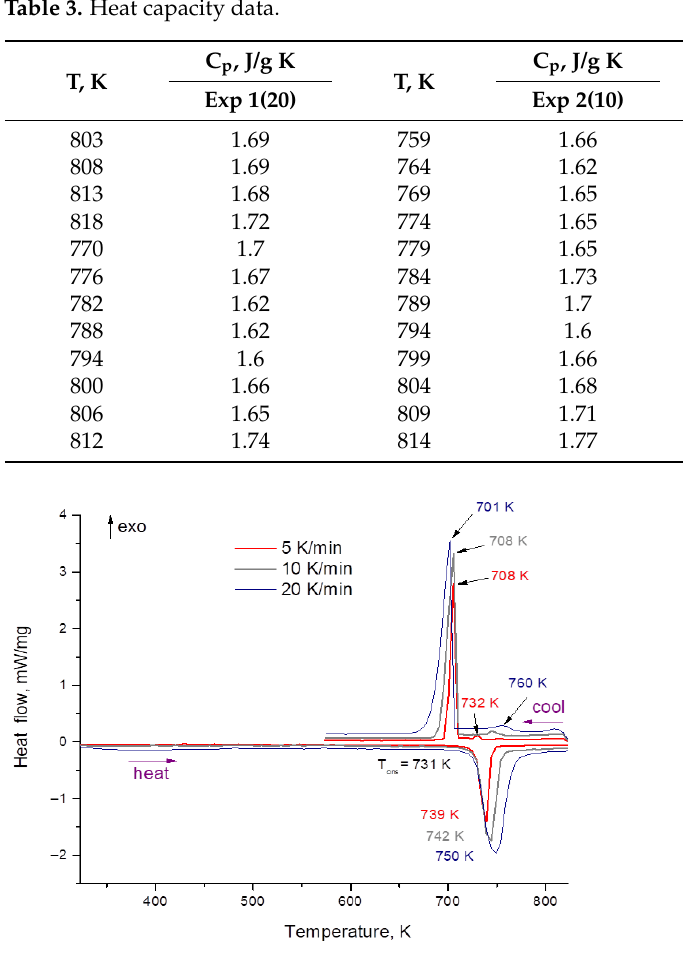
Table 3. Heat capacity data.